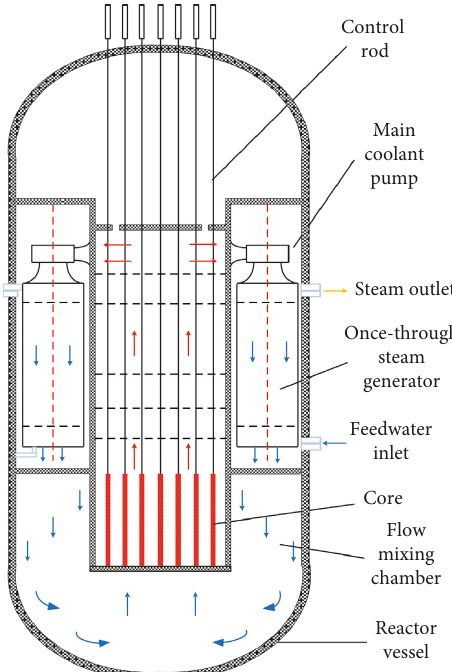
Figure 1: Layout of the IP200 reactor